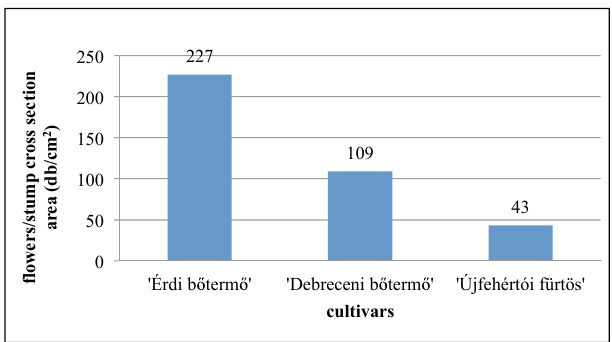
Figure 2 . Specific flower number of the totally rejuvenated sour cherry trees two years after the pruning (Debrecen – Pallag, 2015).